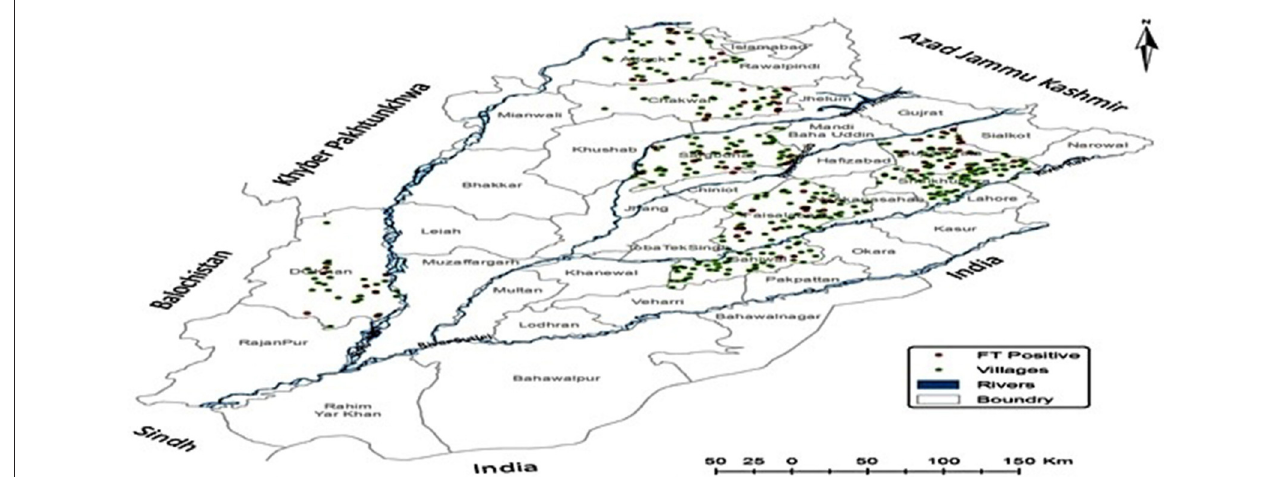
FIGURE 1 | Geographical distribution of Francisella tularensis-positive soil samples in 8 districts.